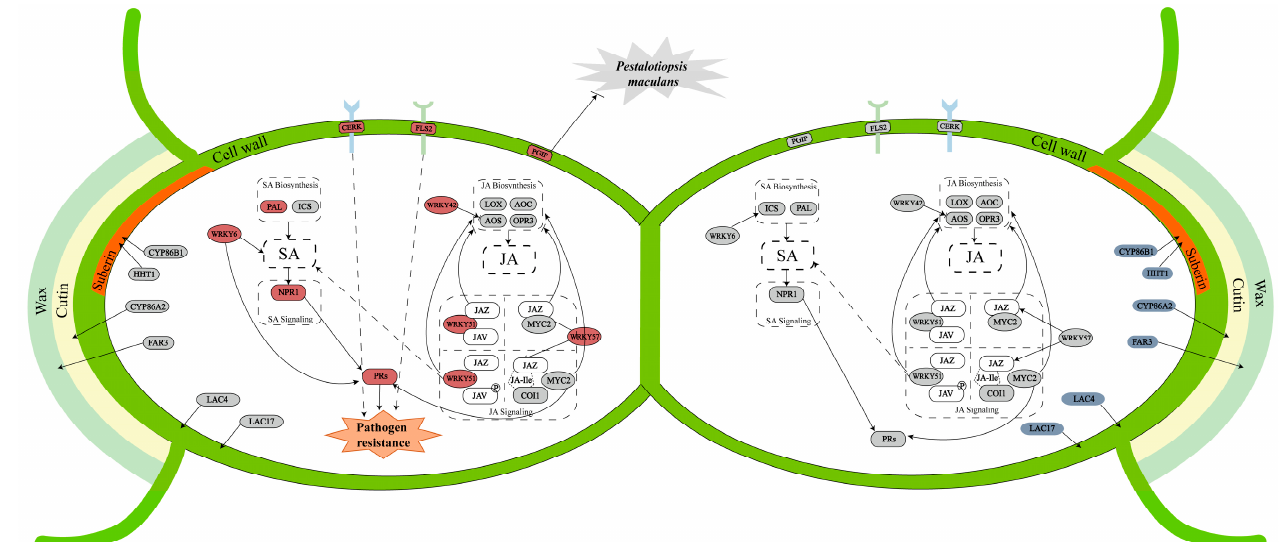
Figure 6. Model depicting the potential regulatory mechanisms involved in resistance to P. maculans in T. distichum ( A ) and T. mucronatum ( B ). Red and blue colors indicate up- and downregulated DEGs, whereas the gray color indicates no obvious changes. SA, salicylic acid; JA, jasmonic acid; CERK1, chitin elicitor receptor kinase 1; FLS2, flagellin sensing 2; JAZ, JASMONATE ZIM-DOMAIN; PAL, phenylalanine ammonia lyase; ICS, isochorismate synthase; NPR1, nonexpressor of pathogenesis-related genes 1; PR, pathogenesis-related; JAV, JASMONATE-ASSOCIATED VQ MOTIF GENE; LOXs, lipoxygenases; AOS, allene oxide synthase; AOC, allene oxide cyclase; OPR3, 12-oxo-phytodienoic acid reductase 3; COI1, coronatine-insensitive 1; HHT, hydroxycinnamoyl-CoA: ω -hydroxyacid/fatty alcohol transferase; FAR3/CER4, fatty acyl–CoA reductase; CYP86A, cytochrome P450 86A; PGIPs, polygalacturonase inhibitor proteins; Lacs, laccases.